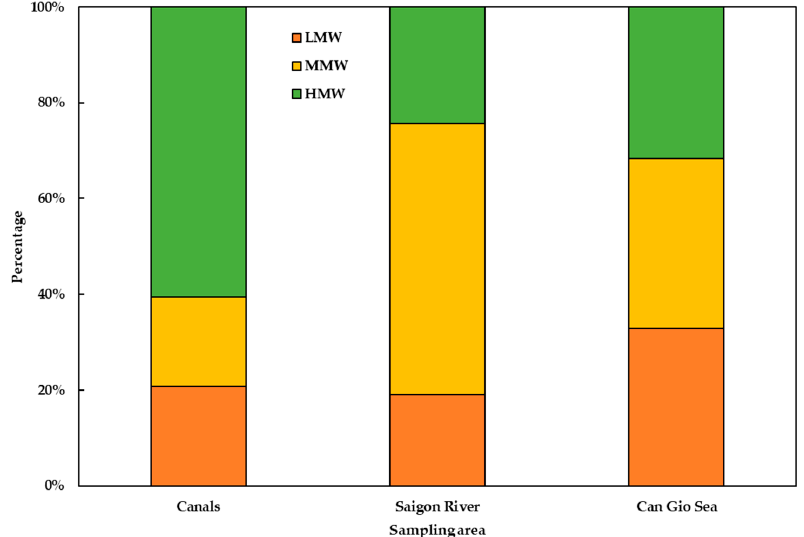
Figure 8. Percentage of PAHs bound to MPs by molecular weight in canals, Saigon River, and Can Gio Sea in August 2020.